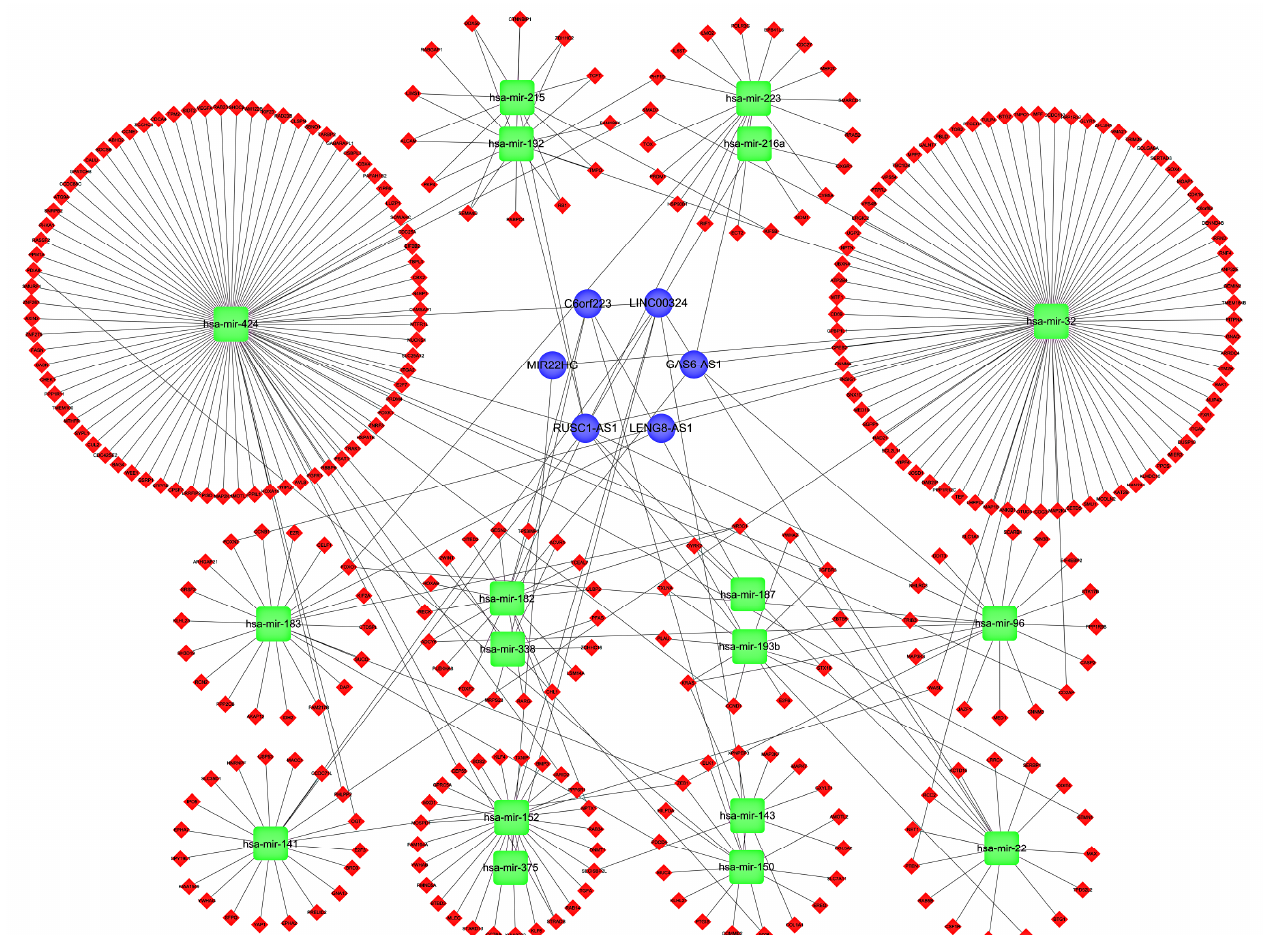
Figure 8. Construction of lncRNA–miRNA–mRNA ceRNA